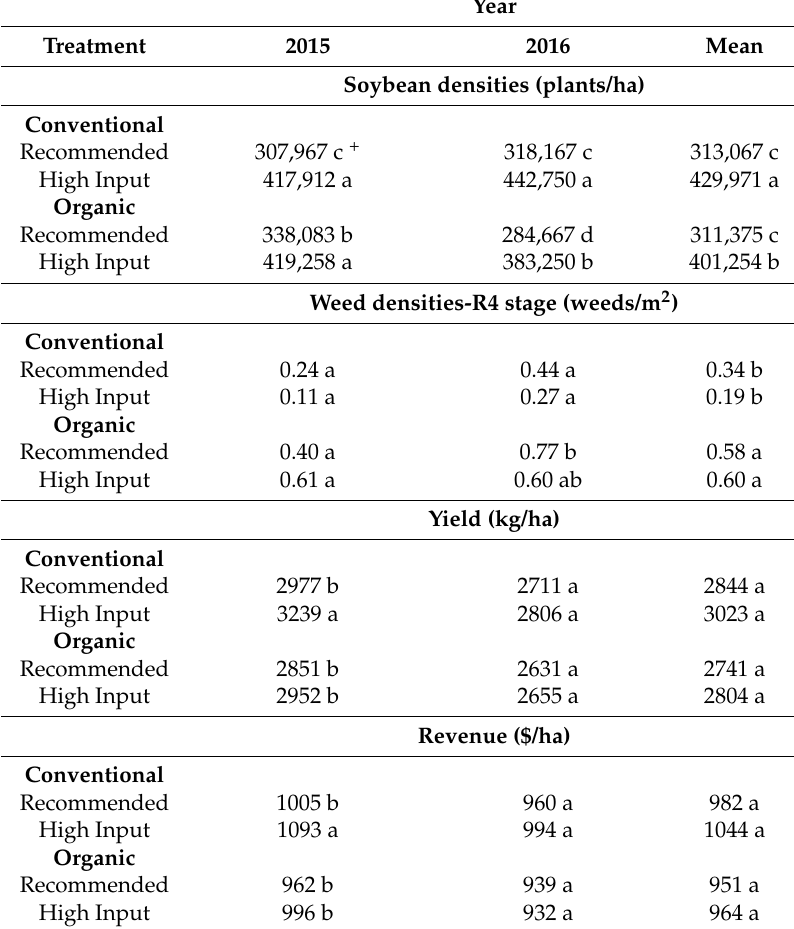
Table 4. Harvest plant densities, weed densities at the full pod stage (R4), seed yield, and revenue of soybean in 2015 and 2016 under conventional and organic cropping systems at recommended and high input management in central